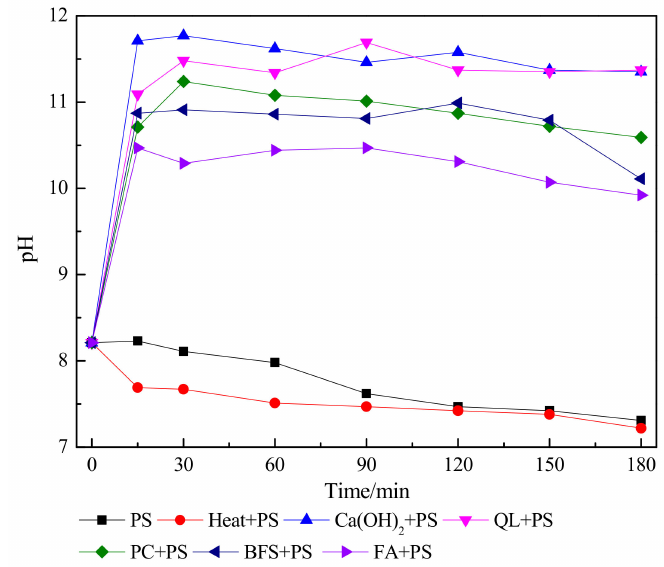
Figure 6. The pH of the system during the 3-h mixing period in all reactions amended with persulfate. See Table S3 for the treatment abbreviations. Persulfate (PS), Quick lime (QL), Portland cement (PC), blast-furnace slag (BFS), and fly ash